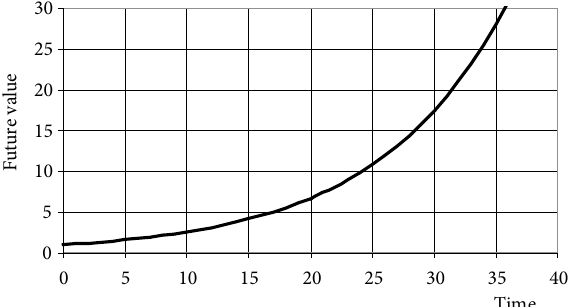
Fig. 3. Exponential future value dependency on time unit (saving